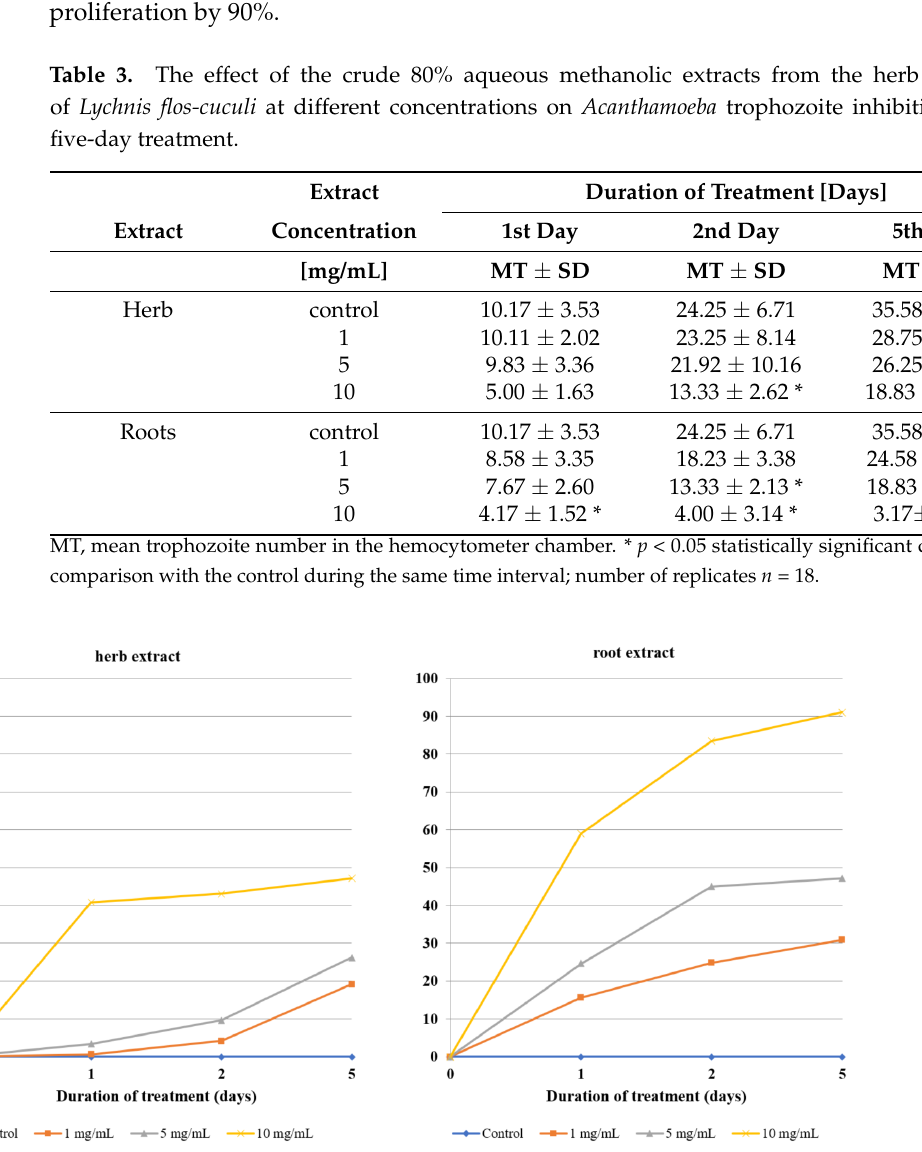
Figure 2. The effect of unfractionated 80% aqueous methanolic extracts from the herb and roots of Lychnis flos-cuculi on the inhibition of Acanthamoeba trophozoite proliferation in the culture medium.